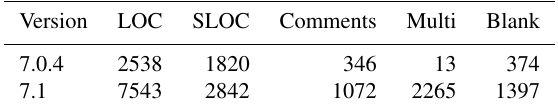
Table 19. Basic metrics.